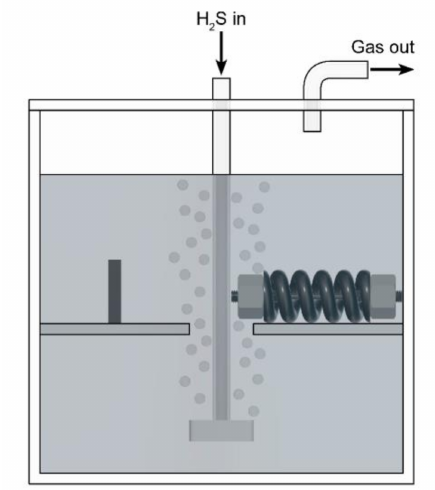
Figure 3. Experimental setup of the tests at ambient pressure